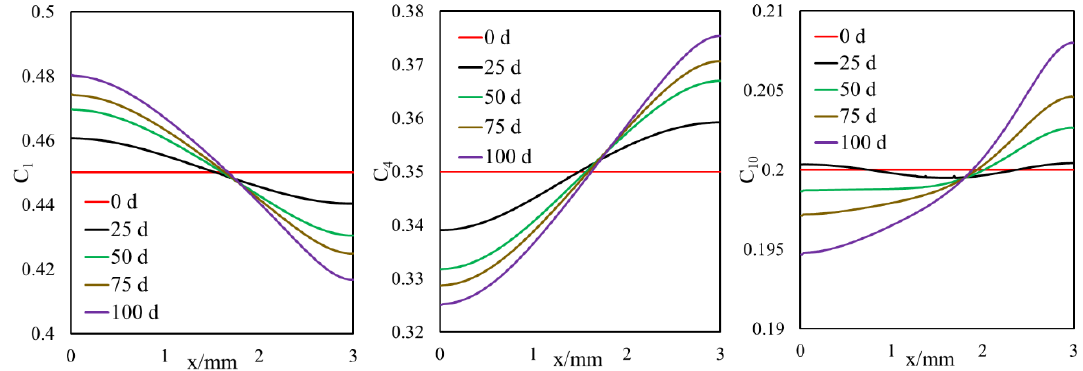
Figure 6. The overall composition of C 1 (left), C 4 (middle), C 10 (right) at di ff erent times, ternary